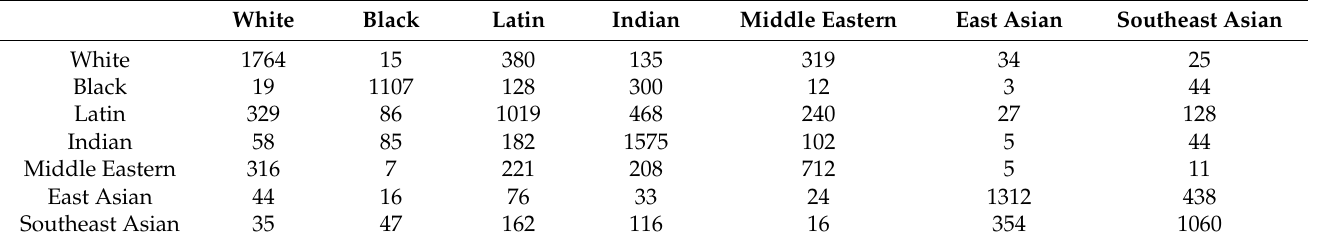
Table 12. Confusion matrix for the FairFace filtered testing without plotted landmarks.